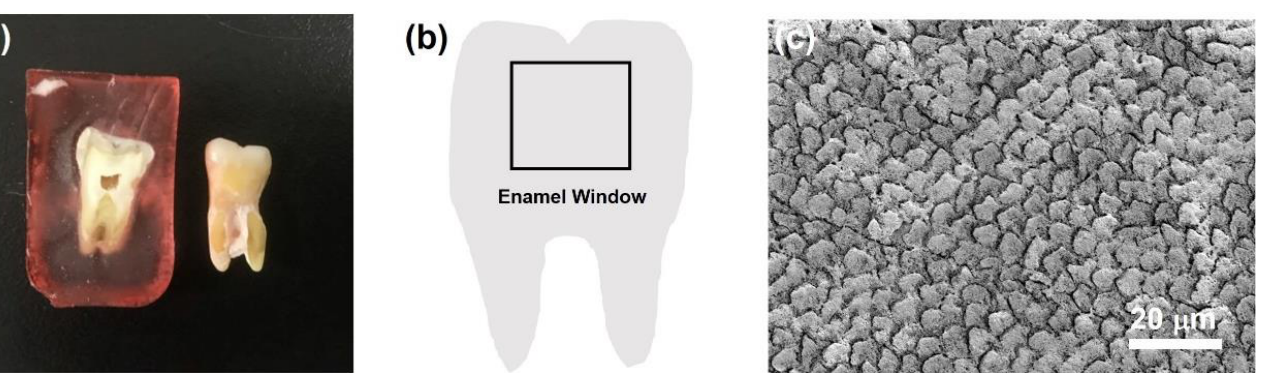
Figure 2. FTIR spectra of the calcium phosphate nanocluster (CaP NC) solution and solid.